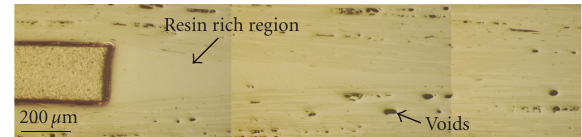
Figure 3: Photomicrograph of the resin pocket area around the embedded dummy sensor: side view (along the fiber direction).